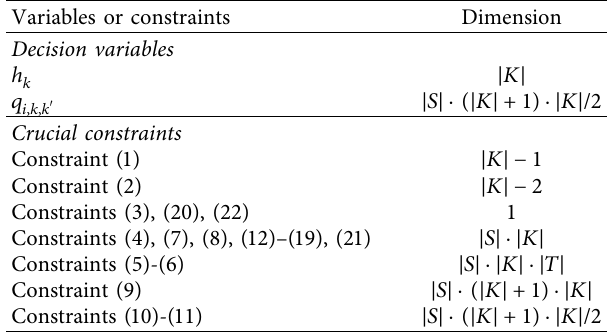
Table 2: Numbers of crucial variables and constraints in the